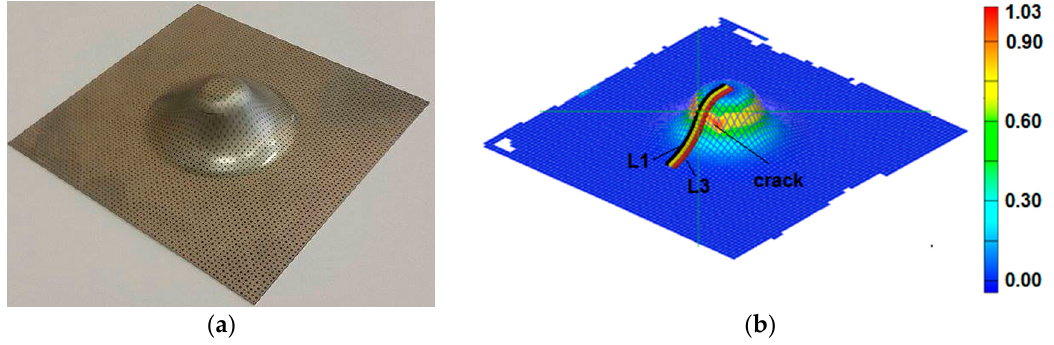
Figure 4. ( a ) Final grid and ( b ) contour of true major principal strain of a tested part by